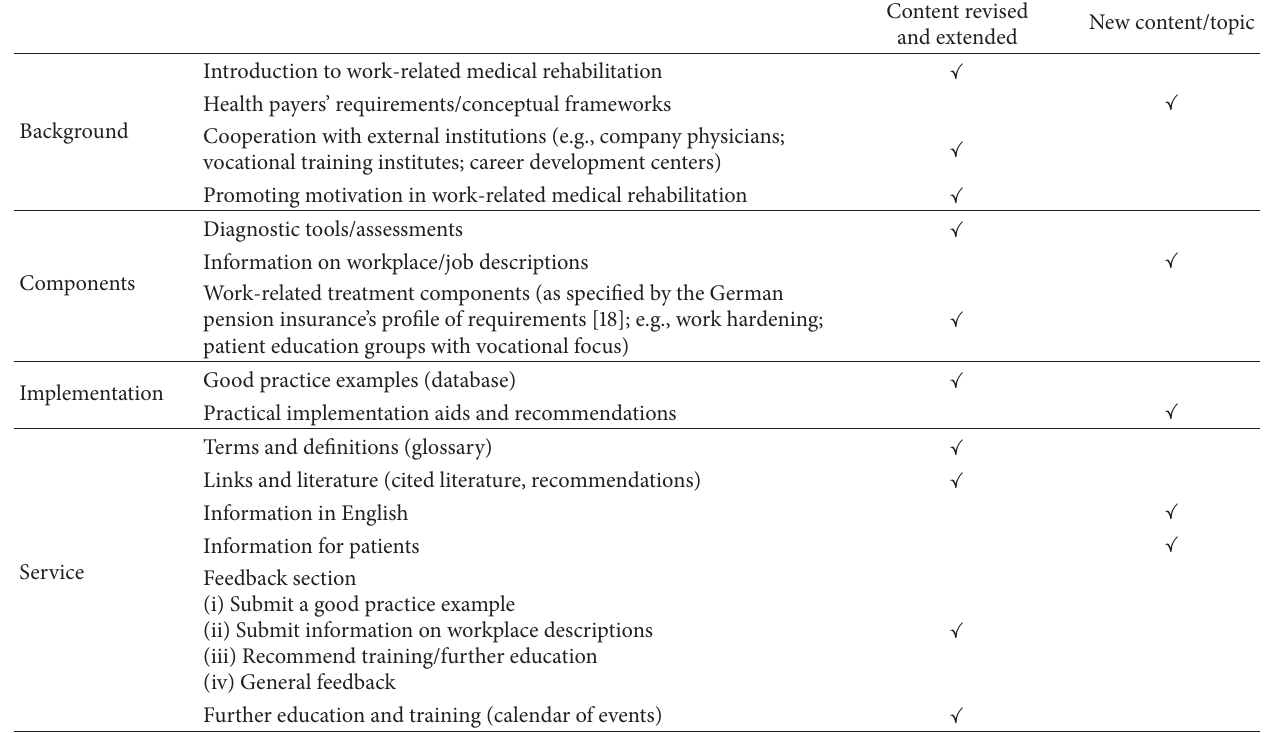
Table 3: Overview of website structure and